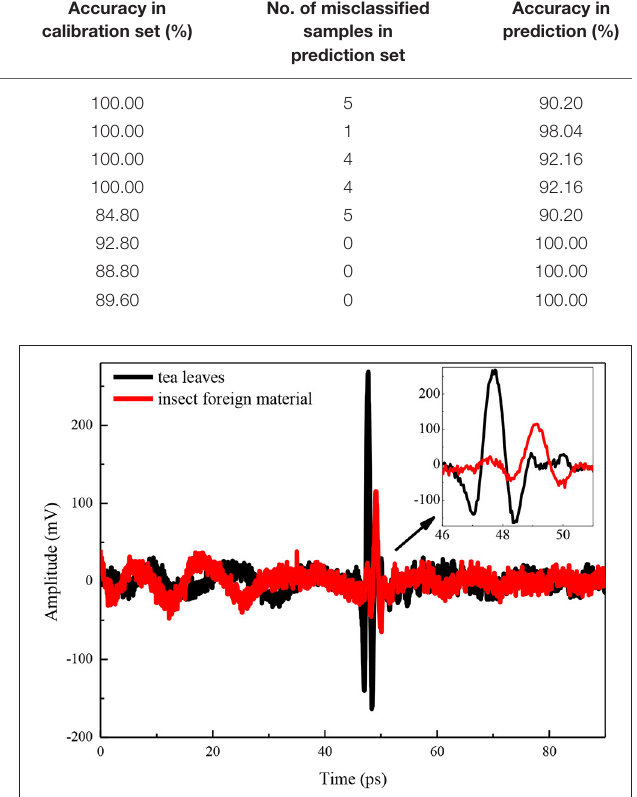
TABLE 1 | Detection results of KNN and PLS-DA models of tea leaves with insects. Modeling method